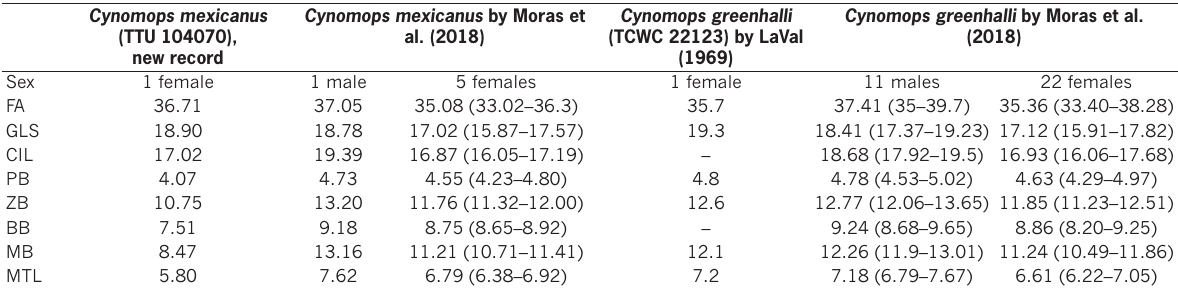
Table 1. Comparison of the new record of C. mexicanus with the record of LaVal (1969) in the department of Comayagua of C. greenhalli , and the measurements presented for both species by Moras et al. (2018). Means (ranges in parentheses); all the mea- surements are in mm. Cynomops mexicanus (TTU 104070),